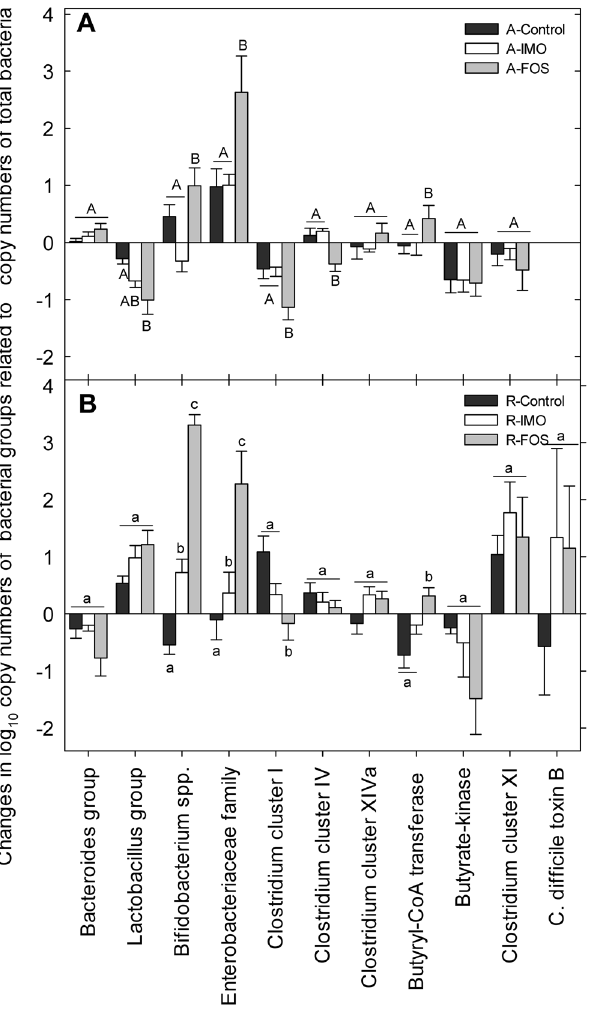
Figure 2. Effects of diets and fibres on fecal bacterial composition. Changes of fecal bacterial composition (week 16 – week 4) in HLA-B27 transgenic rats was evaluated by qPCR. AIN-76A diet is shown in panel A, whereas panel B depicts the results for rat chow diet. Vertical bars represent means and standard error of the mean. Values obtained with the same primer pair that do not share a common superscript are significantly different ( P , 0.05, Bonferroni adjustment).